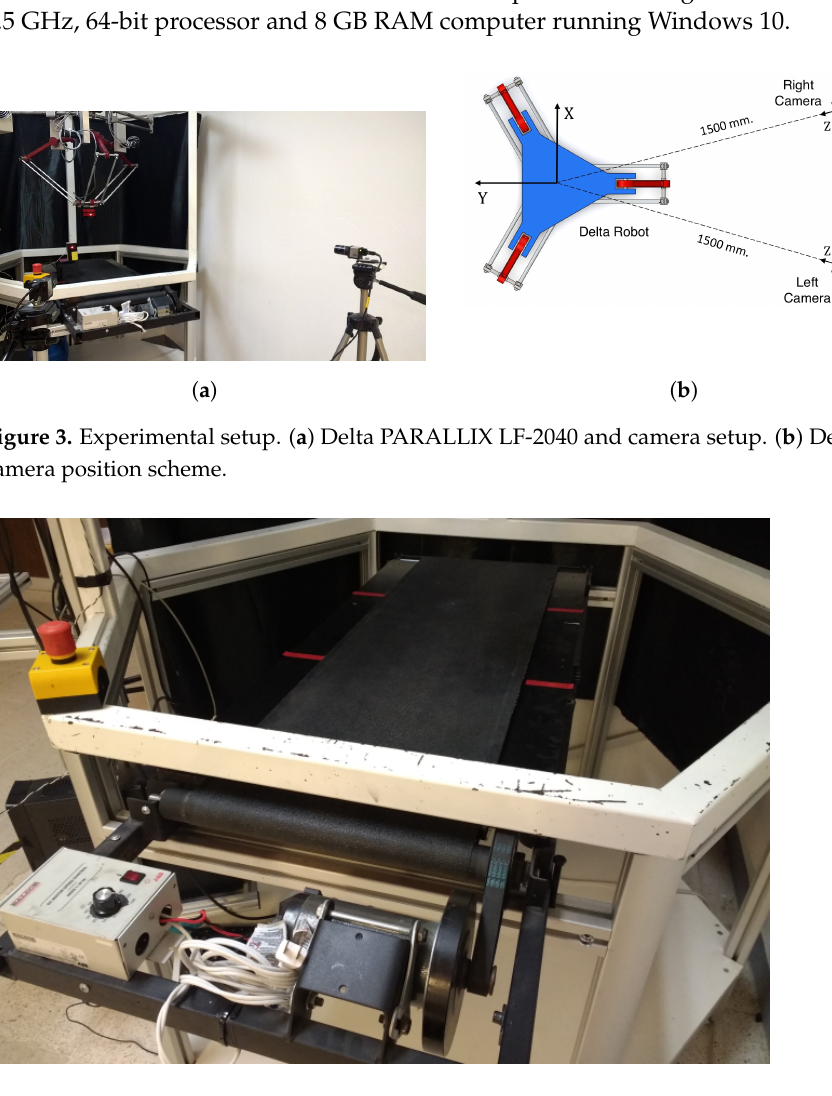
Figure 4. Conveyor